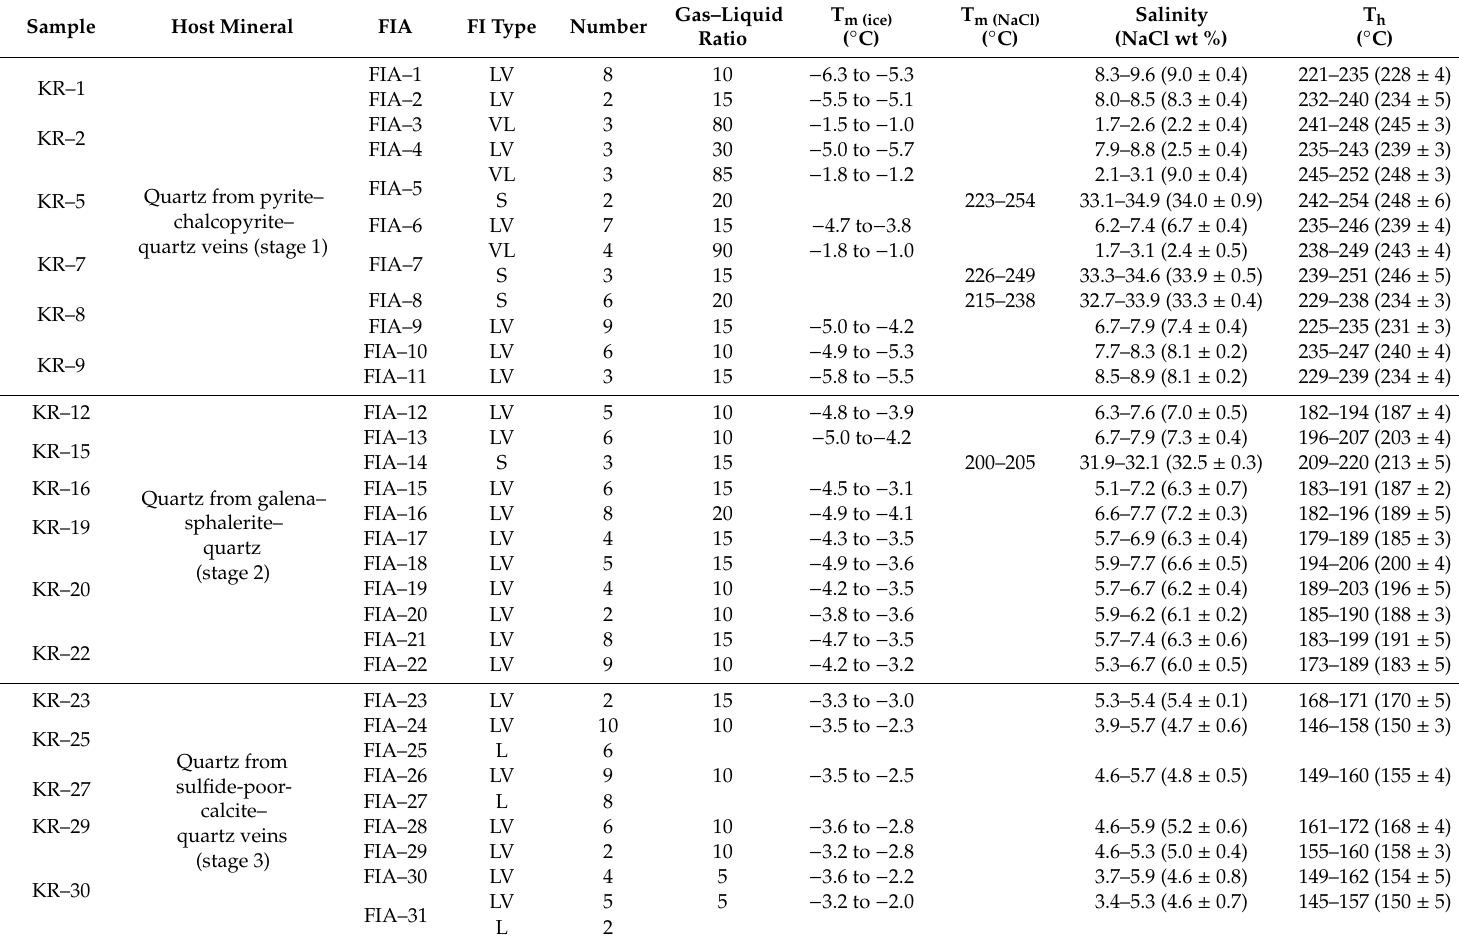
Table 1. Microthermometric data from FIAs in hydrothermal quartz of the Kuergasheng Pb–Zn